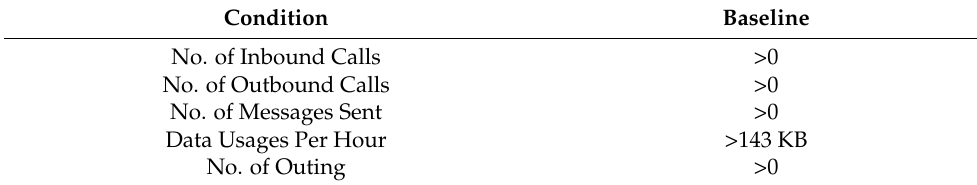
Table 3. Verifying conditions of communication data.